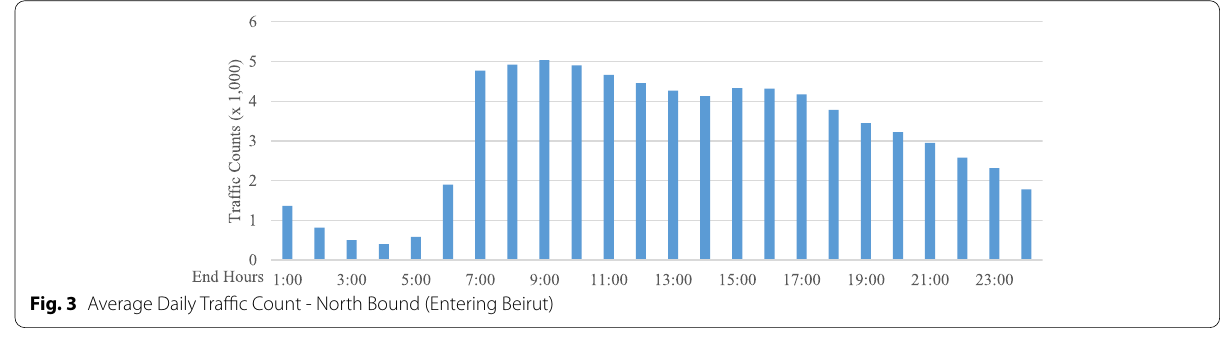
Fig. 3 Average Daily Traffic Count ‑ North Bound (Entering Beirut)